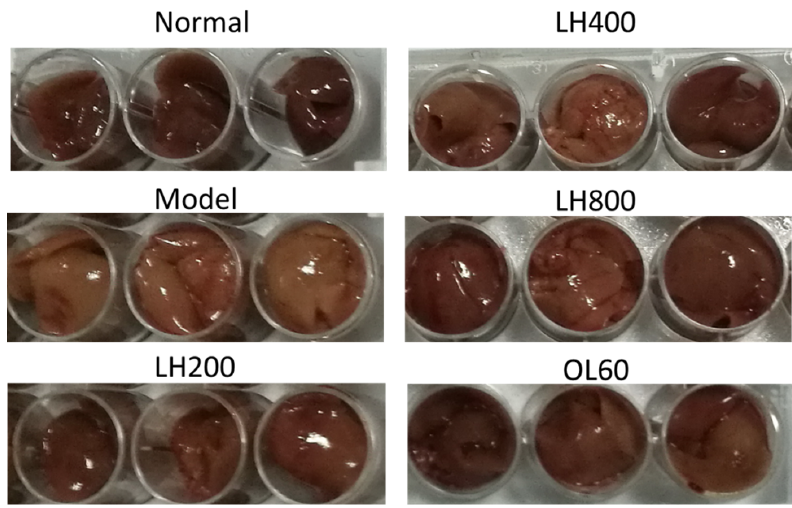
Figure 4. Effects of LH on the color of mouse livers. Normal, normal group; model, high-fat control group. LH200, LH400, and LH800: groups orally treated with LH at dosages of 200, 400, and 800 mg/kg/day, respectively; OL60: group orally treated with OL at 60 mg/kg/day (n = 10).